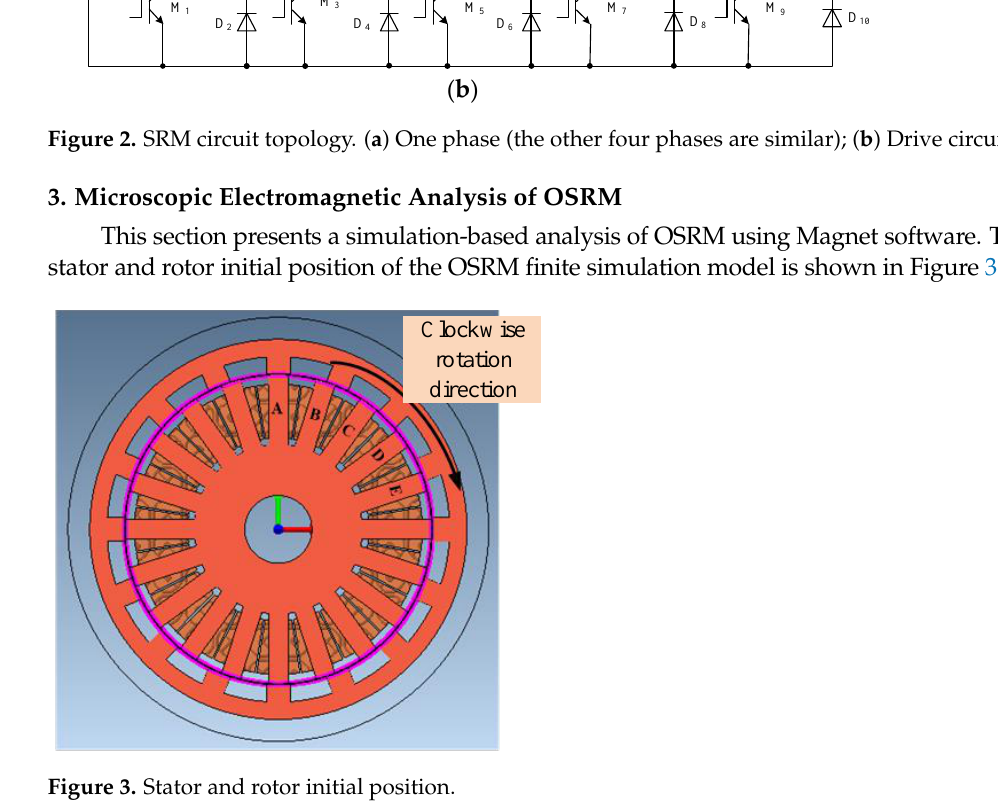
Figure 3. Stator and rotor initial position.